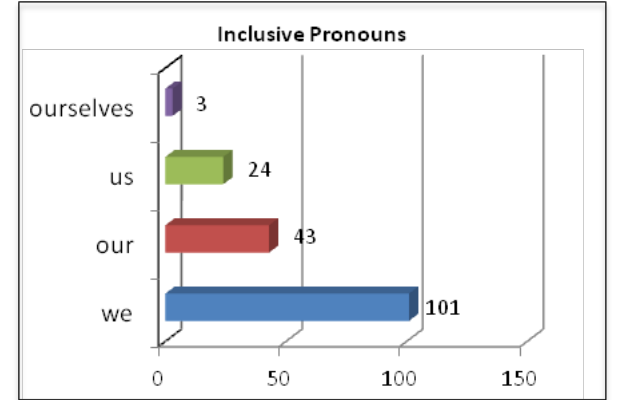
Figure 2. Inclusive pronouns in the